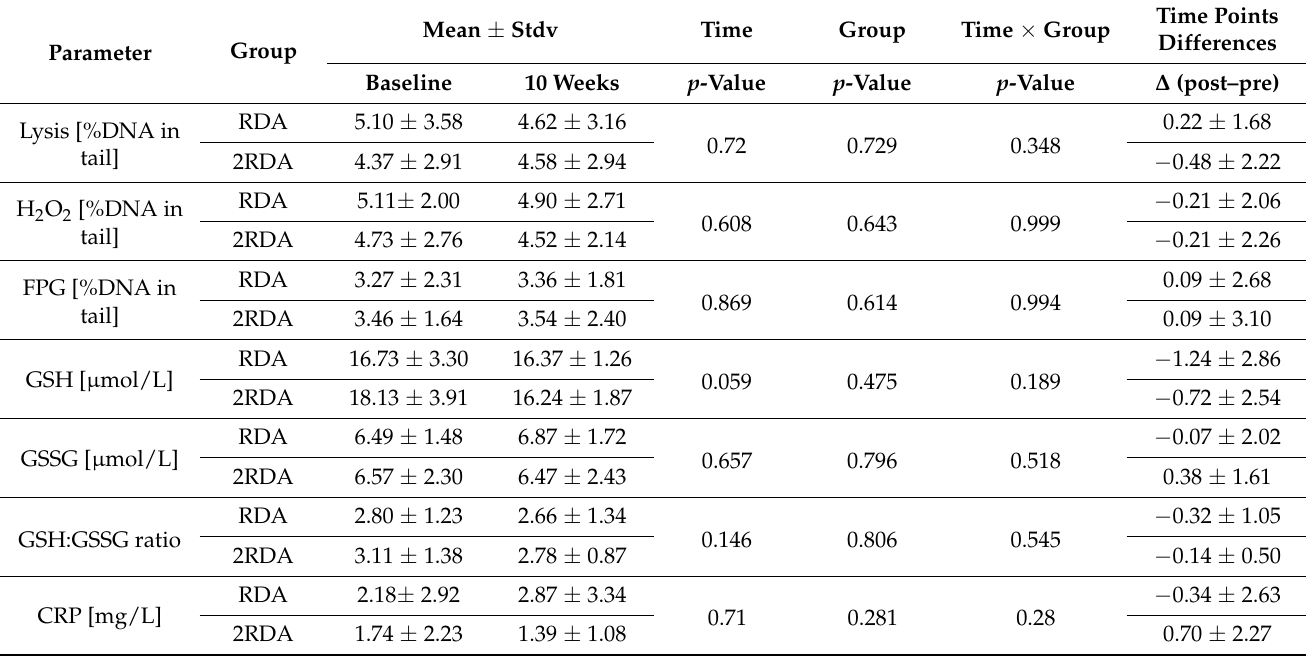
Table 7. Impact of the protein intervention on DNA damage marker in the New Zealand